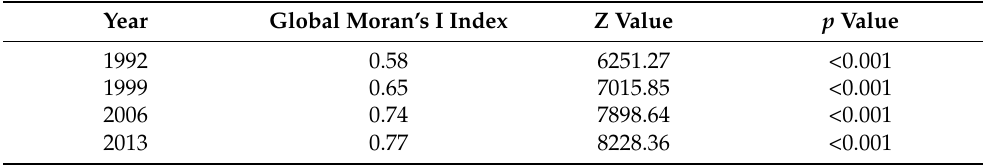
Table 2. EPC global Moran’s I index statistics for the three major urban agglomerations of YREB from 1992 to